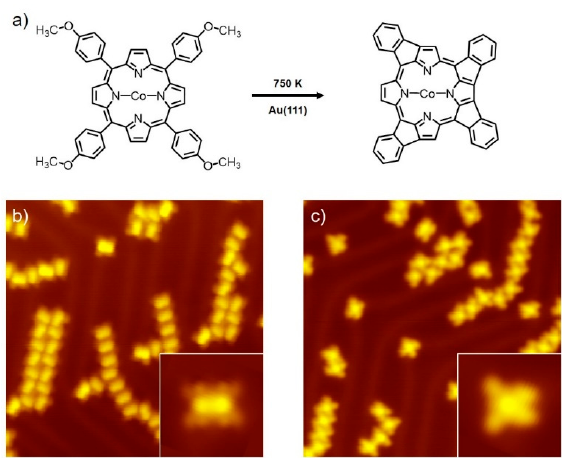
Figure 1. ( a ) Schematic illustration of the DHC reaction of Co(TAP) into the reaction product at 750 K on Au(111); ( b ) STM image of Co(TAP) adsorbed on Au(111) at room temperature and at low coverage; inset: enlarged STM image of an individual Co(TAP) molecule; (c) STM image of the DHC product generated from 750 K annealing of the sample in ( b ); inset: enlarged STM image of an individual DHC product. Imaging conditions for STM images were − 0.3 V and 20–50 pA. Image size for ( b , c ): 30 × 30 nm 2 ; size for inset images: 4 × 4 nm 2 .